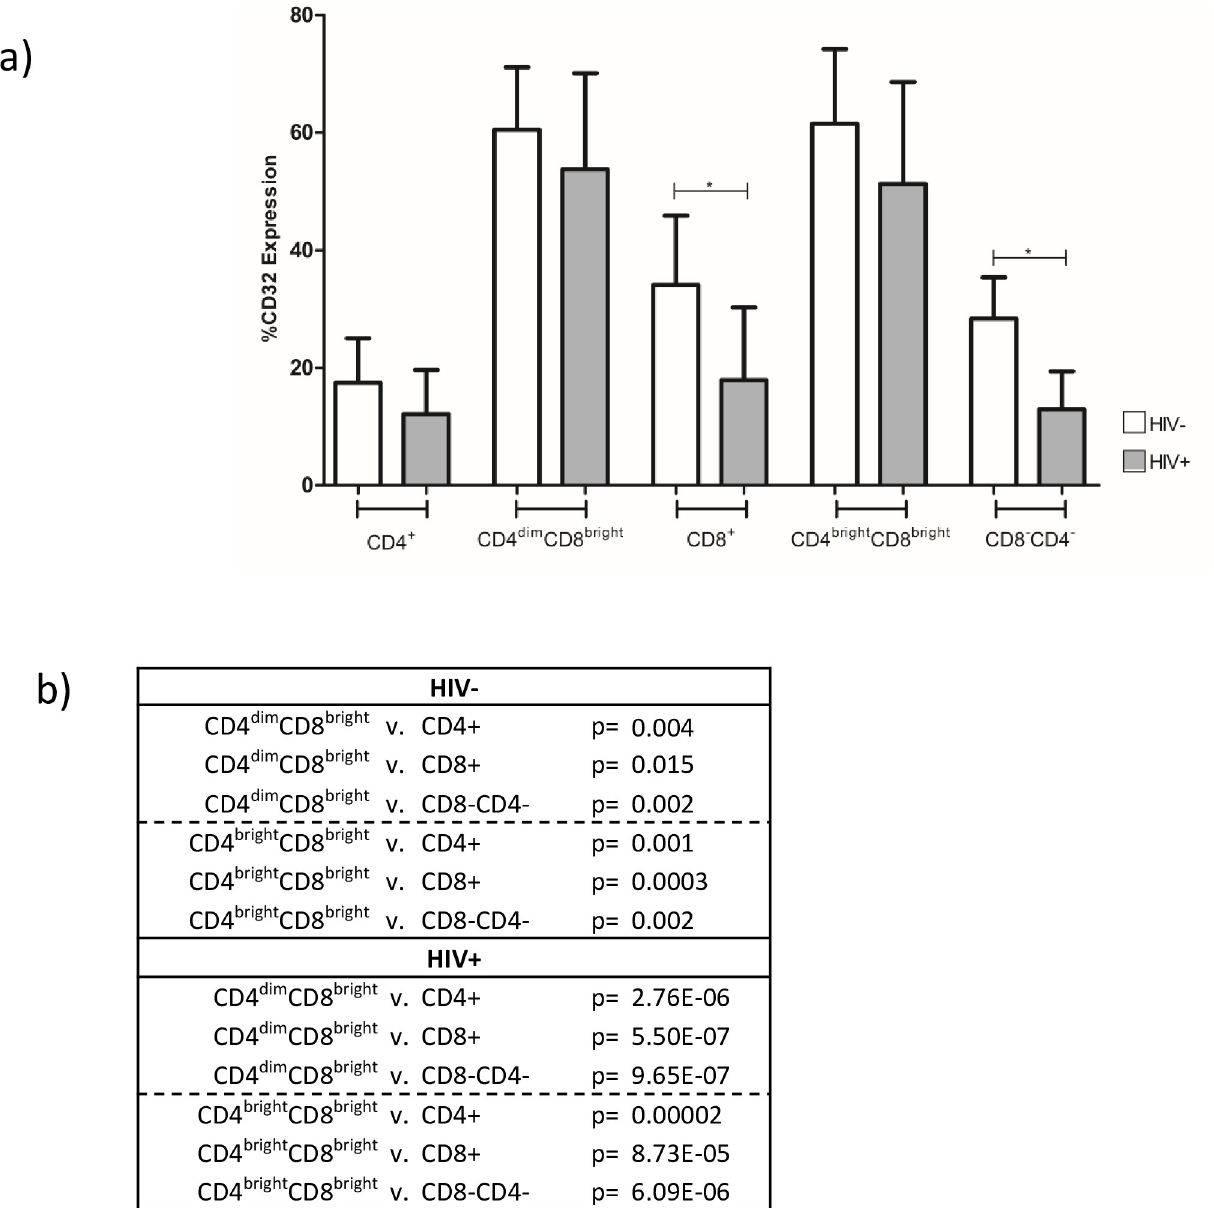
Fig 3. CD32 expression is higher on various CD4 and CD8 double positive T cell subsets. a) CD32 expression was determined on five T cell populations: CD8 + , CD4 dim CD8 bright , CD4 + , CD4 bright CD8 bright , and CD8 - CD4 - cells. Positive CD32 was gated using FMO as a negative control. Expression of CD32 on each population was compared between HIV - and HIV + donors. � denotes p < 0.05 as measured by unpaired T-test. b) Within group comparisons of CD32 expression on T cell populations in HIV - and HIV + donors was determined via